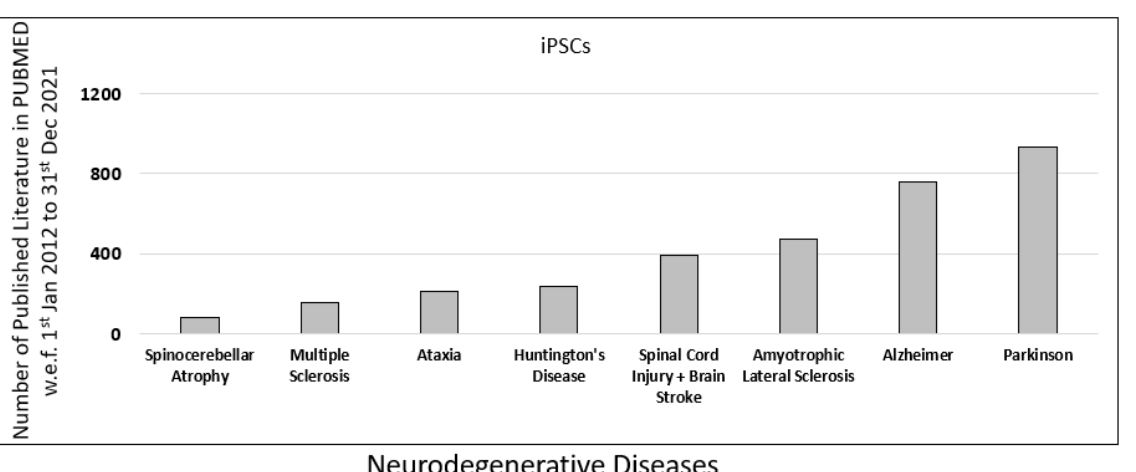
Figure 2. Published data for iPSCs research in the last decade. Comparison of different diseases such as cancer, heart disease, neurodegenerative disease, diabetes, liver disease, autoimmune disease, cartilage regeneration, Zika virus, and SARS-CoV-2 based on scientific research published in PUBMED in the last decade (w.e.f. 1 January 2012 to 31 December 2021).